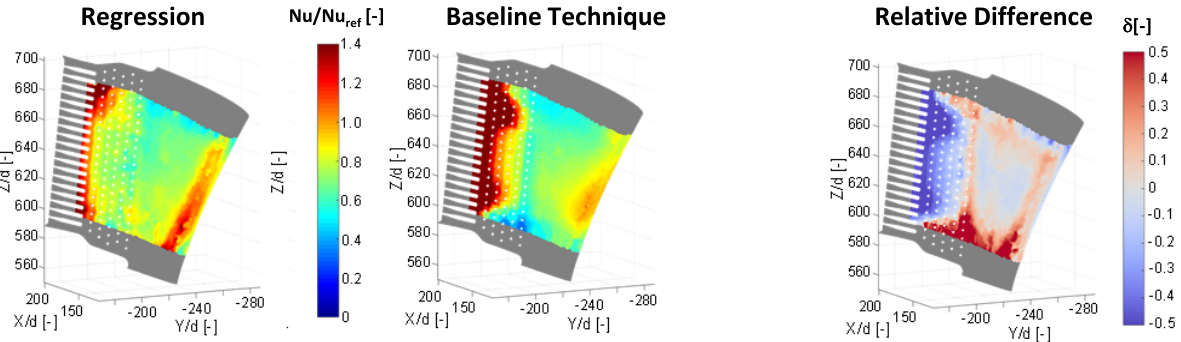
Figure 9. Heat transfer distribution obtained by linear regression methodology for the maximum Re value.